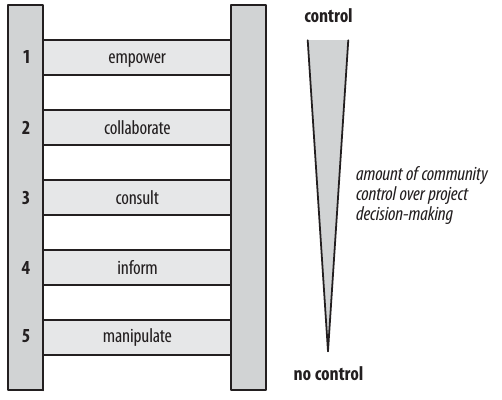
Figure 1. Ladder of community